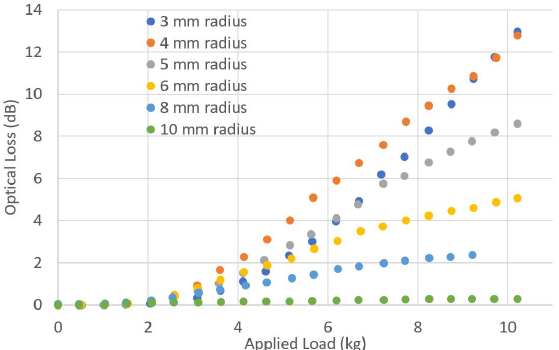
Figure 7. Varying the impactor radius to assess the impact on the optical loss of SSMF under applied load. All impactors were made of hard PVC